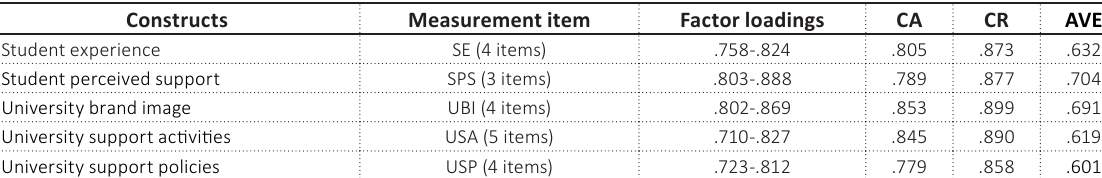
Table 1. Internal consistency reliability and convergent